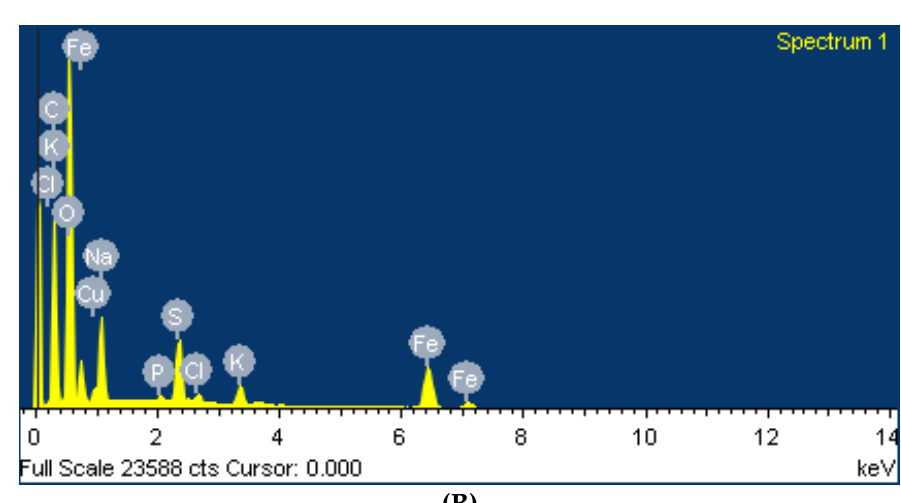
Figure 3. ( A ) FTIR spectrum of FeNP and ANE; and ( B ) Energy Dispersive Spectroscopy (EDS) analysis of the synthesized FeNP.